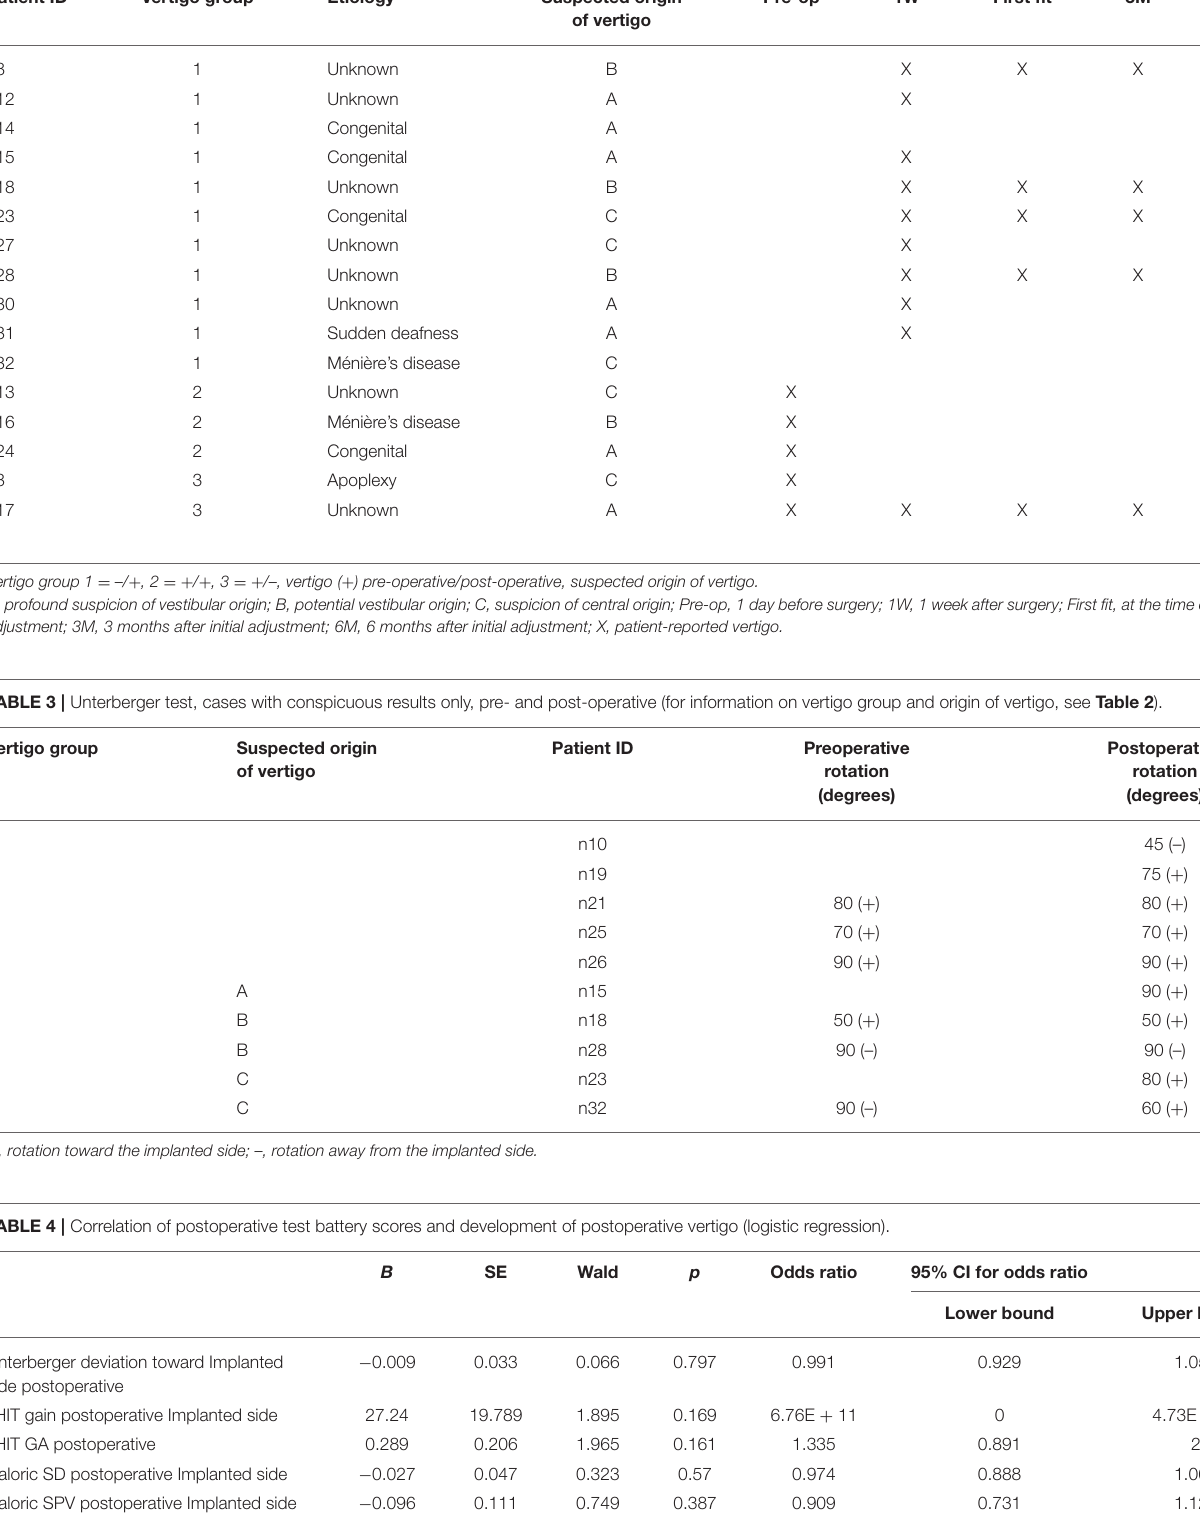
TABLE 2 | Chronological overview of the occurrence of vertigo (cases without any occurrence of vertigo excluded). Patient ID